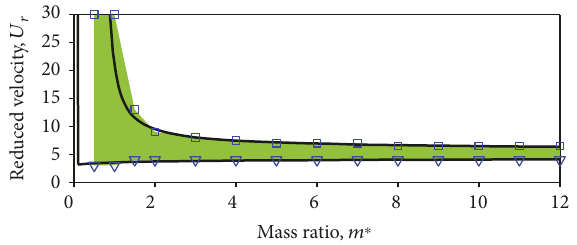
Figure 10: Comparison of predicted lock-in boundaries for a circular cylinder: □ , upper boundary (current implementation); ∇ , lower boundary (current implementation); lock-in region (current implementation) (in green) and [32] (in black